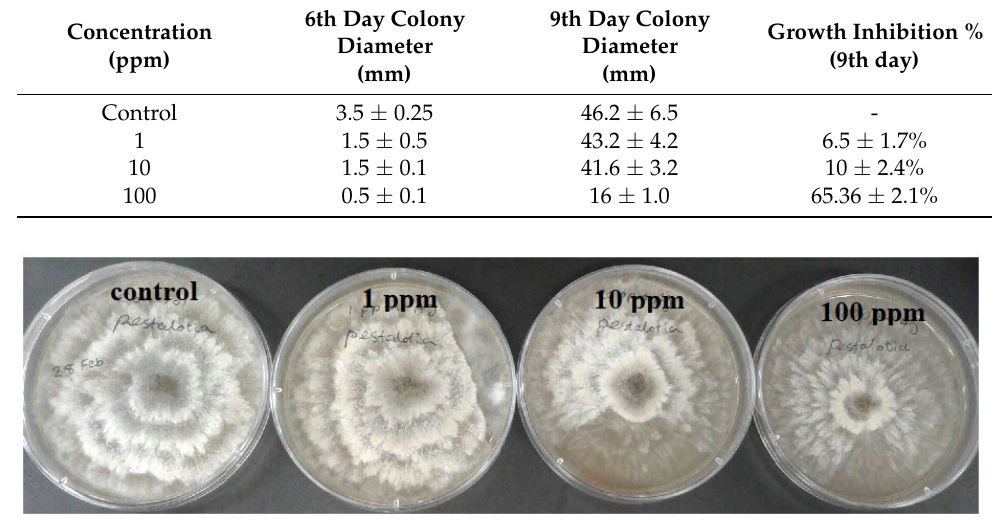
Figure 2. Effect of different concentrations of Ag NP on the growth of B. cinerea after 9 days: control and treatments with Ag NPs of 0 (as control) 1, 10, and 100 ppm concentrations, agar dilution method.